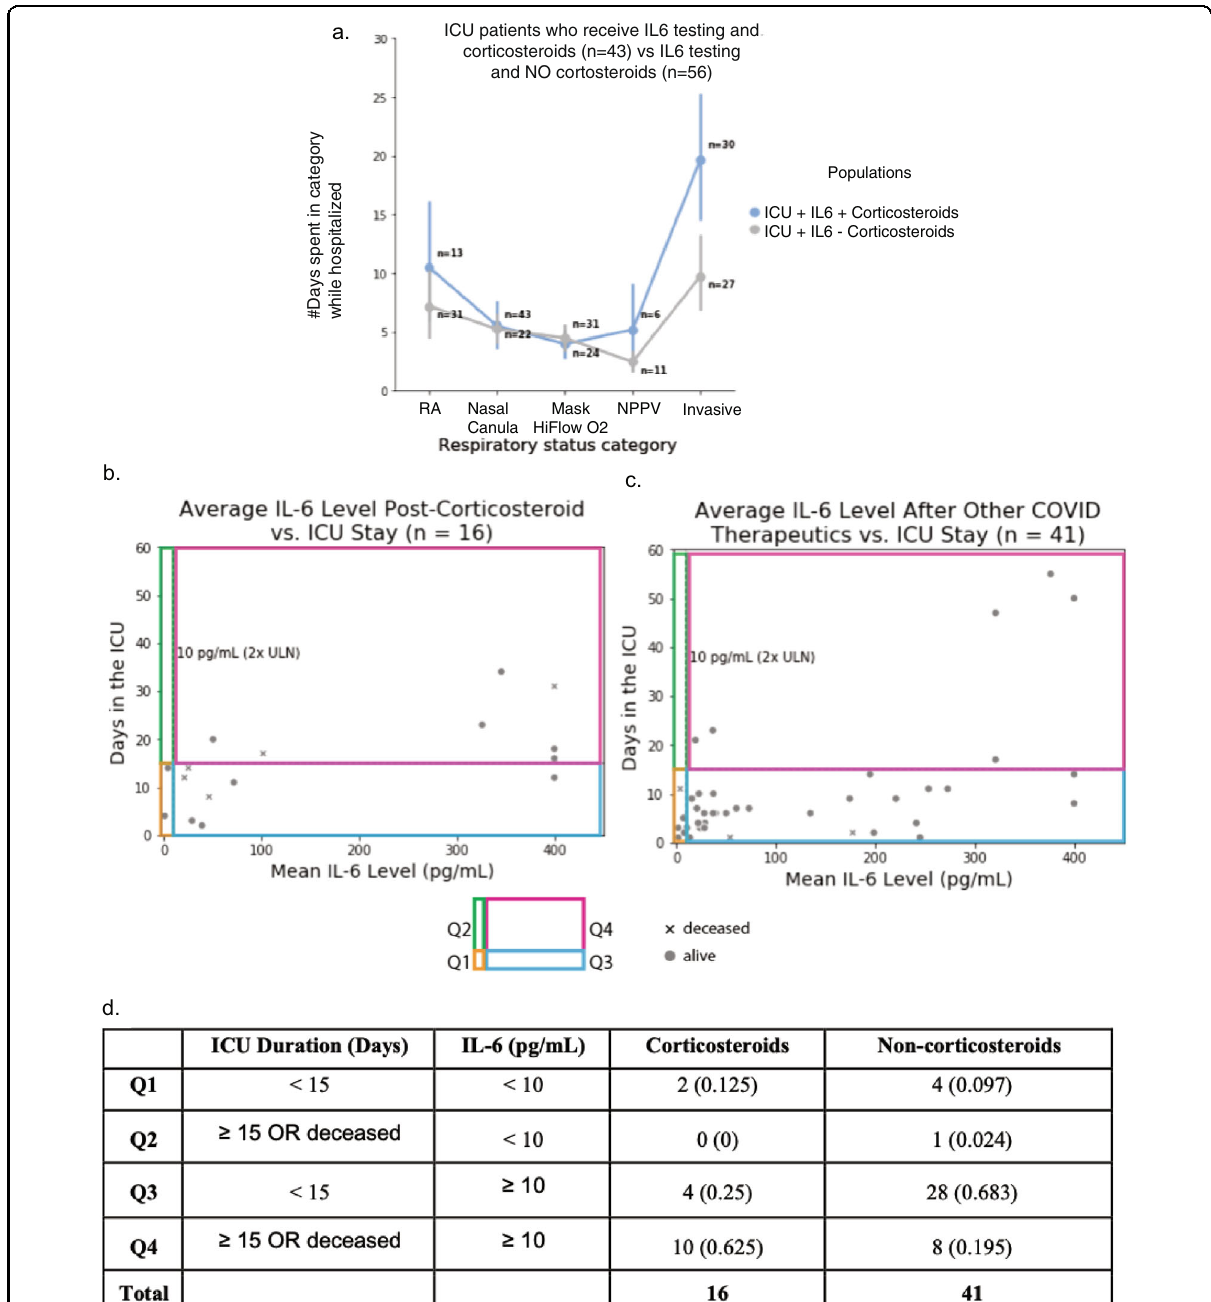
Fig. 1 Relationship between IL-6 levels and ICU duration for COVID-19 ICU patients who had at least one plasma IL-6 measurement after administration of either corticosteroids or other classes of drugs. a Among the COVID19 patients that were admitted to ICU at some point during their hospital stay and had undergone an IL6 test, the patients that were on corticosteroids ( n = 43) experienced longer durations on higher levels of respiratory support compared to the patients that were not on corticosteroids ( n = 56). b Relationship between ICU duration and IL-6 levels following the administration of non-topical corticosteroids for n = 21 ICU patients who received corticosteroids. c Relationship between ICU duration and IL-6 levels following the administration of one or more of the following drugs: tocilizumab, azithromycin, hydroxychloroquine, or antivirals ( n = 64 patients); these patients did not receive corticosteroids. d Summarizing the number of patients in each of the four quadrants (Q1, Q2, Q3, and Q4) in ( b ) and ( c ) above. A Fisher exact test of proportions suggests that a higher proportion of patients who receive corticosteroids and have an IL-6 value over 10 pg/mL have poor outcomes (ICU stay ≥ 15 days or death) when compared to the equivalent proportion of those treated with non- corticosteroid drugs including antivirals, tocilizumab, azithromycin, and hydroxychloroquine ( p =